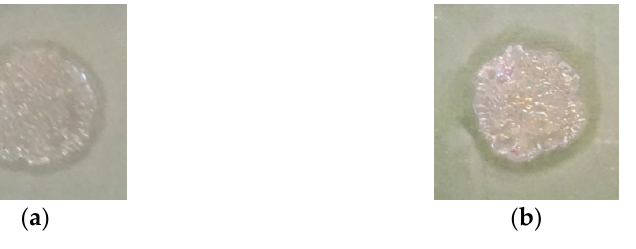
Figure 6. Images of clear zones around discs (10 mm in diameter) of CTA-Ag in contact with ( a ) E. coli and ( b ) S. aureus .